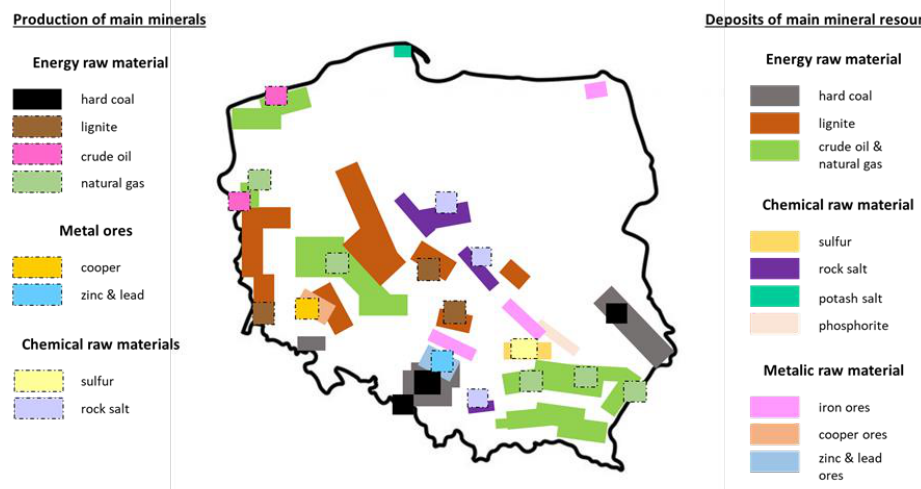
Figure 2. Distribution of main groups of mineral raw materials in Poland. Own elaboration based on [38].